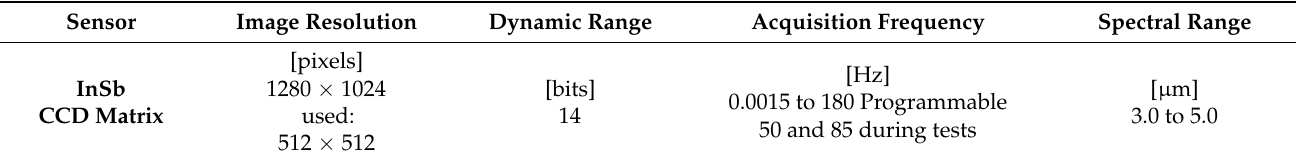
Table 3. Infrared camera specifications.